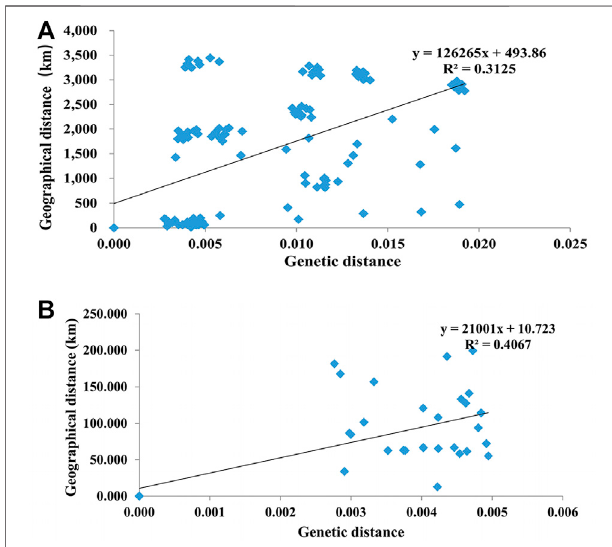
FIGURE 2 | The correlation between genetic distance and geographical distance among 17 populations in China (A) and nine populations in the Western Tianshan Mountains (B) of A. mali